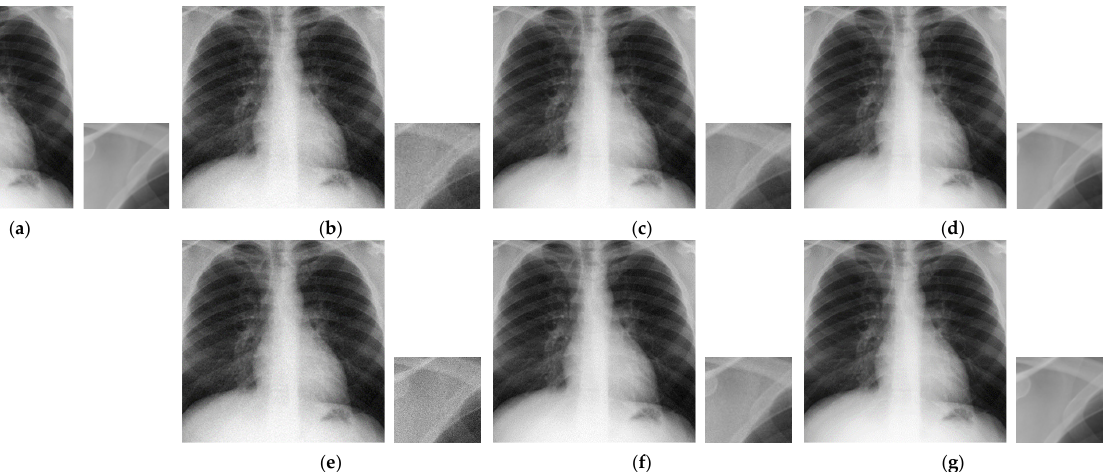
Figure 7. Example images of the proposed noise-based augmentation method. ( a ) is original image. ( b – d ) are conventional method decoded noisy images. ( e – g ) are proposed method decoded noisy images. The JPEG quality factor is set to (80, 90, 100) from left to right. The top left corners are zoomed in every image and are shown beside them.